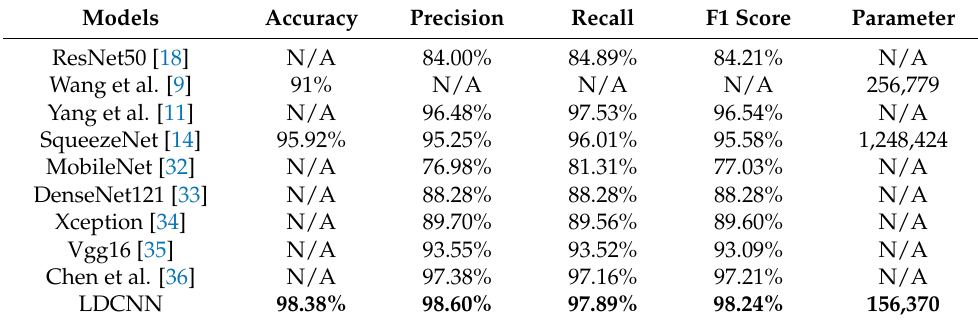
Table 5. Comparison of using a public dataset.